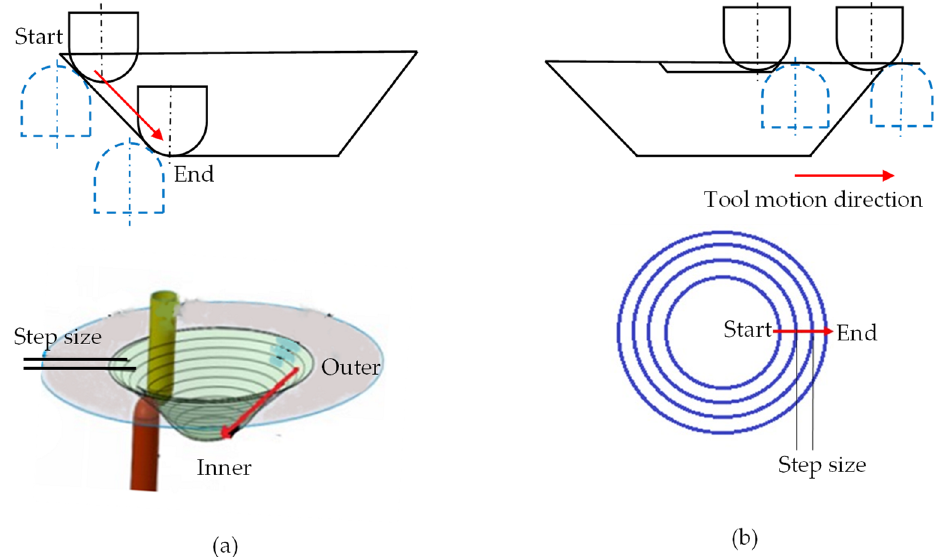
Figure 2. Schematics of ( a ) DISF ( b ) ADSIF toolpath.